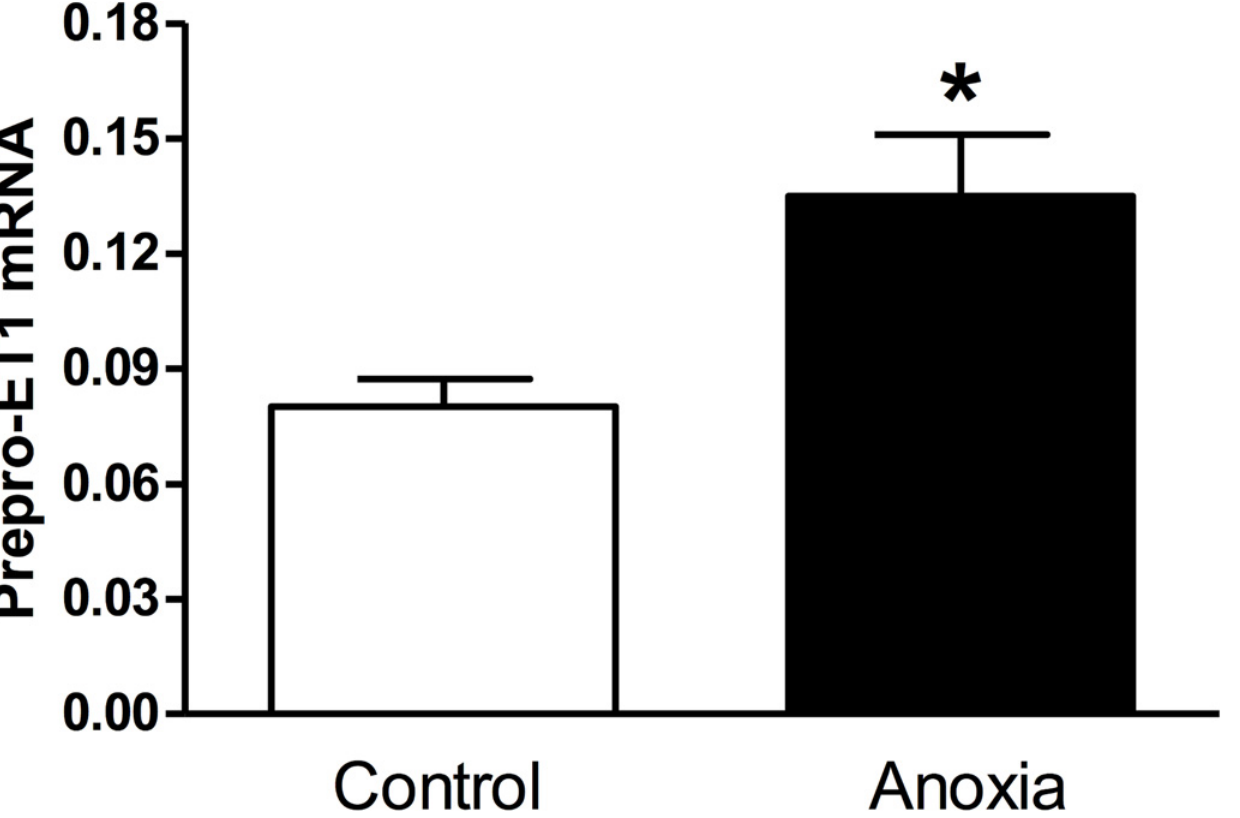
Fig 1. Effect of newborn anoxia on prepro-ET-1 mRNA in the neonatal heart. Hearts were isolated from day 4 neonatal rats treated with control or anoxia. mRNA abundance of prepro-ET-1 was determined by real-time RT-PCR. Data are means ± SEM. * P < 0.05, anoxia vs . control. n = 3 – 5.